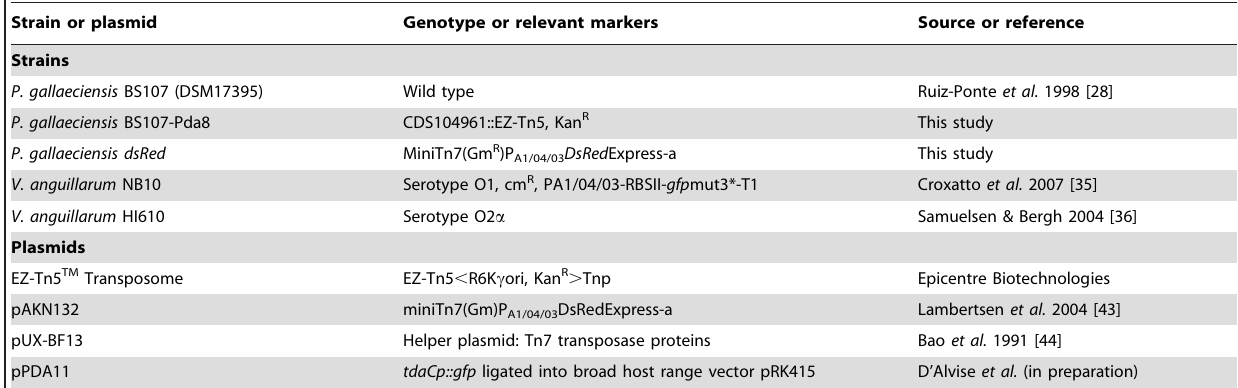
Table 1. Bacterial strains and